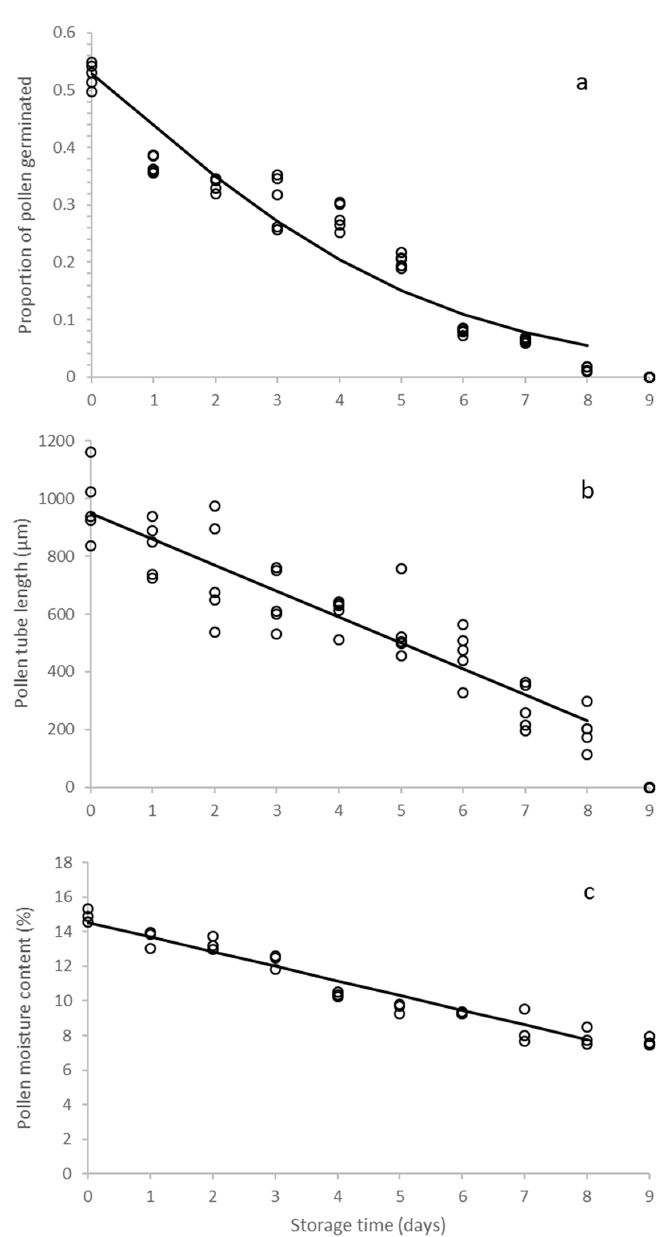
Figure 2. Response of germinability and moisture content of fresh pollen in ambient conditions (21 ◦ C, 60% RH) for up to 9 days: proportion of pollen germinated ( a ), mean pollen tube length ( b ) and moisture content ( c ). Open circles are mean values in ( a ) and ( b ) ( n = 4) and raw values in c. Lines are fitted regressions: y = 0.005x 2 − 0.1038x + 0.5334 ( a ), − 90.065x + 949.43 ( b ), − 0.8457x + 14.543 ( c ).